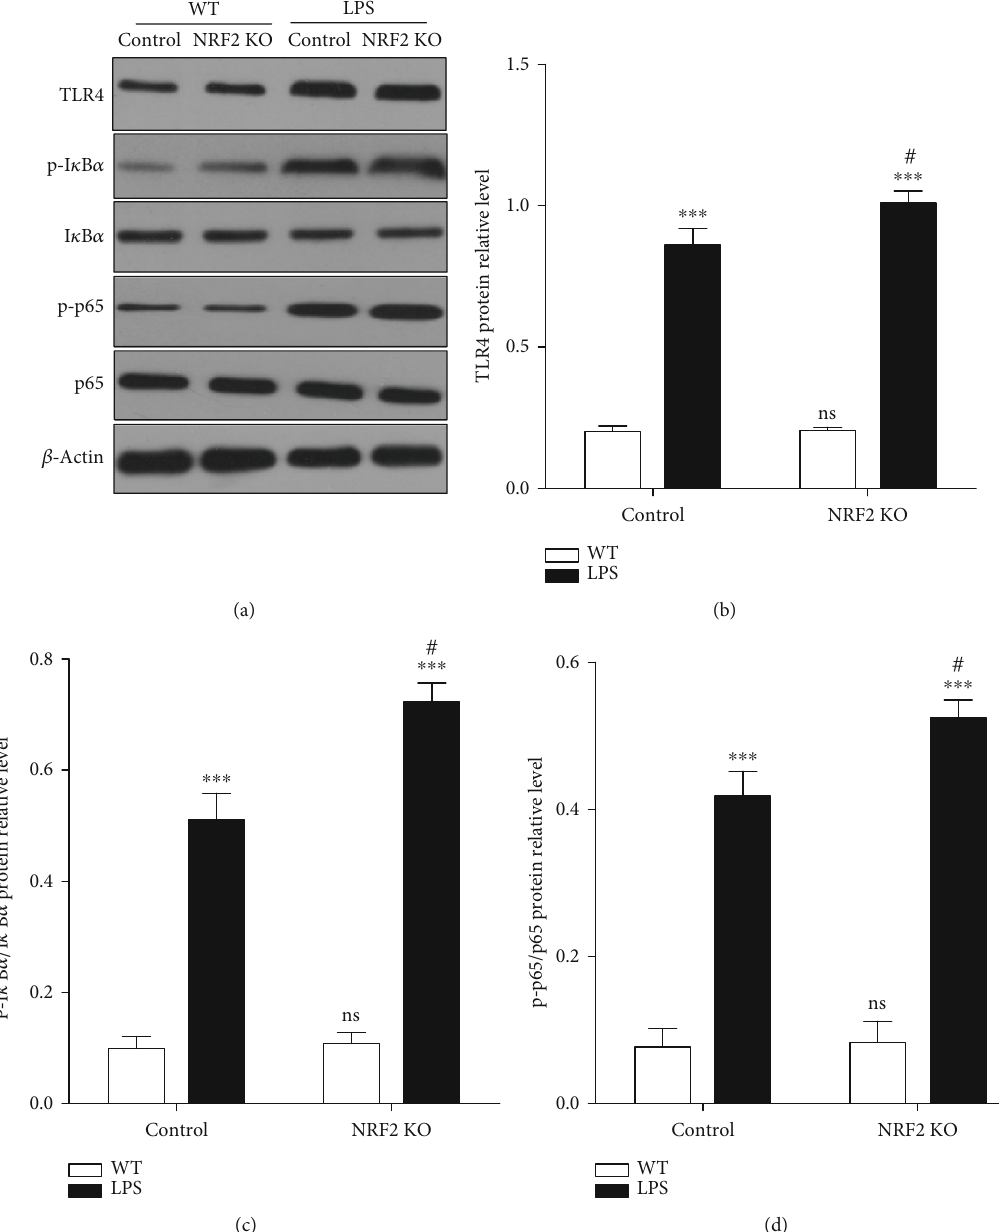
Figure 4: Depleting NRF2 increased LPS-induced the activation of TLR4/NF- κ B pathway. Control and NRF2 knockout (KO) gEECs were stimulated with or without 8 μ g/mL LPS for 12 hours and (a) then detected protein expression by immunoblotting and quanti fi ed TLR4 (b), p-I κ B α /I κ B α (c), and p-p65/p65 (d) protein expression. Data shown are mean ± SD ; ns was P > 0 : 05 , and # was P < 0 : 05 vs. control group; ∗∗∗ was P < 0 : 001 vs. WT group. P value was calculated by the one-way ANOVA with Tukey ’ s test as a posthoc